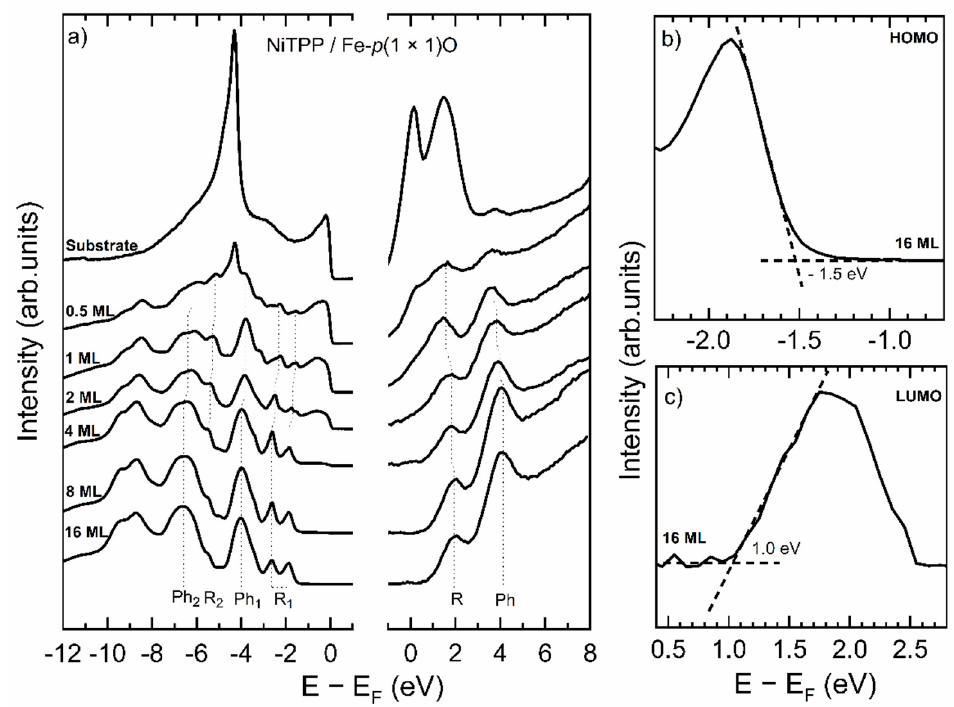
Figure 3. ( a ) UPS (left) and IPES (right) spectra acquired on the system NiTPP/Fe– p (1 × 1)O. The spectra are positioned from top to bottom at increasing NiTPP thickness. Dot lines highlight the evolution of the energy position of peaks attributable either to the macroring (R, R 1 and R 2 ) or to the phenyl groups (Ph, Ph 1 and Ph 2 ). ( b ) Energy region around the HOMO for the 16 ML NiTPP/Fe– p (1 × 1)O sample. The HOMO energy is evaluated as the interception between the zero line and the tangent line to the rising edge in the inflection point (dash lines). ( c ) Energy region around the LUMO for the 16 ML NiTPP/Fe– p (1 × 1)O sample. A linear background was subtracted to the peak. The LUMO energy is evaluated as the interception between the zero line and the tangent line to the rising edge in the inflection point (dash